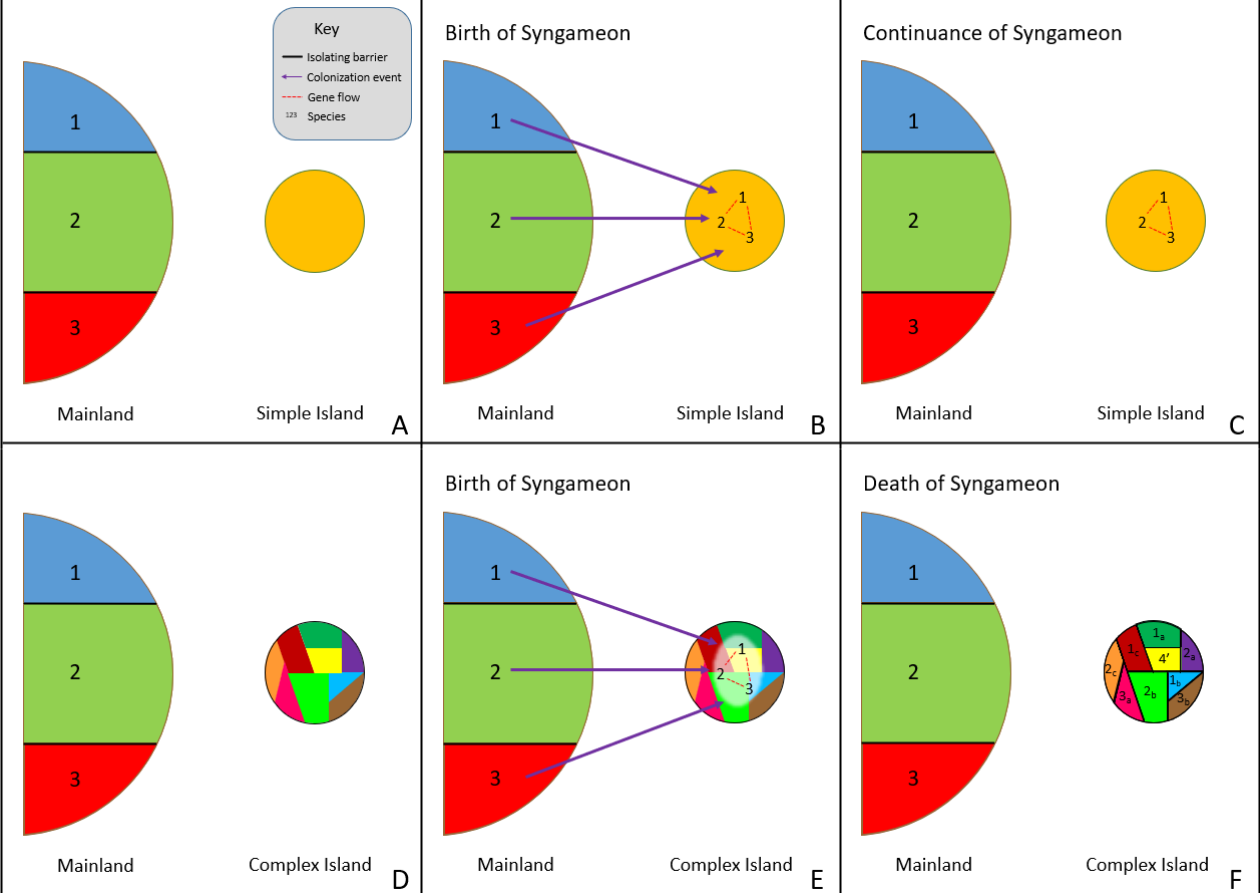
Figure 2. Surfing syngameon hypothesis, in which previously isolated species (1, 2, and 3) come into contact during the colonization of a low-complexity island ( B ) and high-complexity island ( E ), re- sulting in hybridization and the formation of a syngameon ( B , E ). The syngameon increases genetic diversity and reduces the effects of bottleneck events, resulting in the successful colonization of an island. If the island is open and uniform ( A – C ), with little to no ecological and geographical com- plexity (simple island), then evolutionary change is slowed down by syngameonic introgres- sion/gene flow, resulting in homogenization of traits and the continuation of the syngameon ( C ). If the island is geographically and ecologically complex ( D – F ), then selection, adaptation, and compe- tition eventually drive divergence and the formation of reproductive isolating barriers, resulting in the eventual collapse of the syngameon ( F ). Participation could even result in the creation of a new hybrid lineage ( F , shown as lineage 4 ′ ). 2.2.3. Edge Range Hypothesis Syngameons may form at the edges of species’ ranges, where multiple species can overlap in distribution (Figure 3A) [23]. Typically, range edges are seen as population sinks because the species is unable to adapt to the new, local environment beyond the current distribution boundary [161]. However, hybridization at a species’ range edge may facilitate survival by introducing locally adapted or novel traits through introgression [161]. Cronk and Suarez-Gonzalez [23] used a poplar syngameon to show how a tri-spe- cies interaction allows for the increased survival of hybrids at the edge of species bound- aries. They also illustrated how as ranges expand and contract, these gene flow events